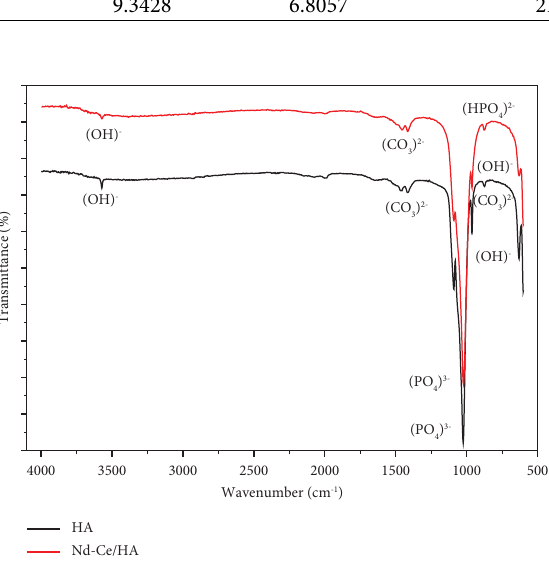
Figure 3: FTIR test of prepared HA and